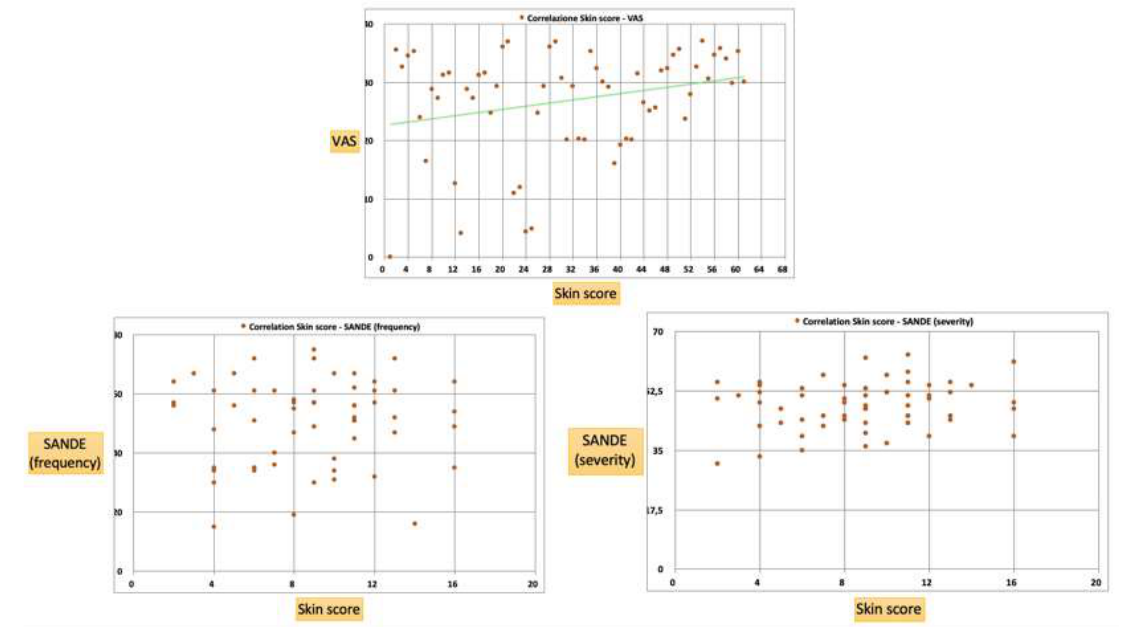
Figure 6. A positive correlation was found between the VAS and the skin score (r = 0.38; p < 0.05), showing marked symptoms in the subjects with a more serious disease. No correlation was found between the SANDE (frequency and severity) and the skin score ( p >